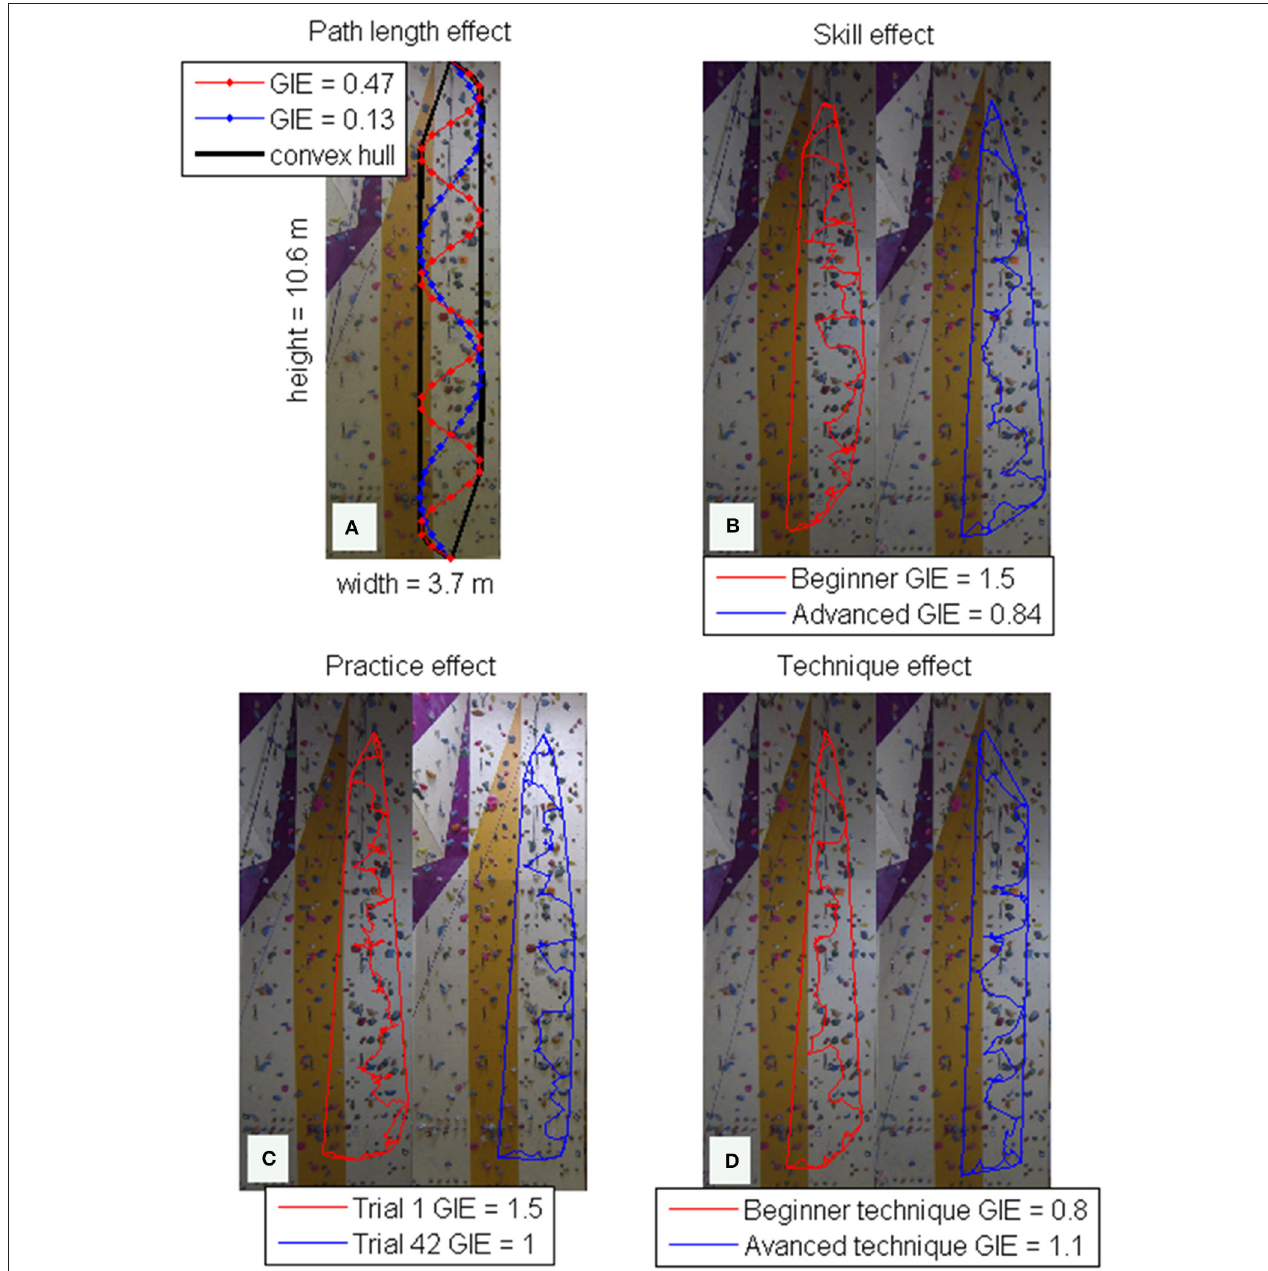
FIGURE 1 | (A) Shows that the shorter the path length within a given convex hull, the lower the geometric index of entropy (GIE). (B) The blue line is data from an advanced climber, who shows a more straight forward trajectory (and thus lower GIE) compared to the beginners climbed trajectory (red line). (C) After practice (the blue line representing a climbed trajectory after 42 trials of practice) typically do not show periods of searching as shown in the first trial of practice (red line on the left). (D) When the technique used is more complex, GIE also increases. Here an individual was asked to climb the same route either with the front of the body remained facing the wall (red line) or with the side of the body facing the wall (blue line). The more advanced technique required an increase in movement complexity.